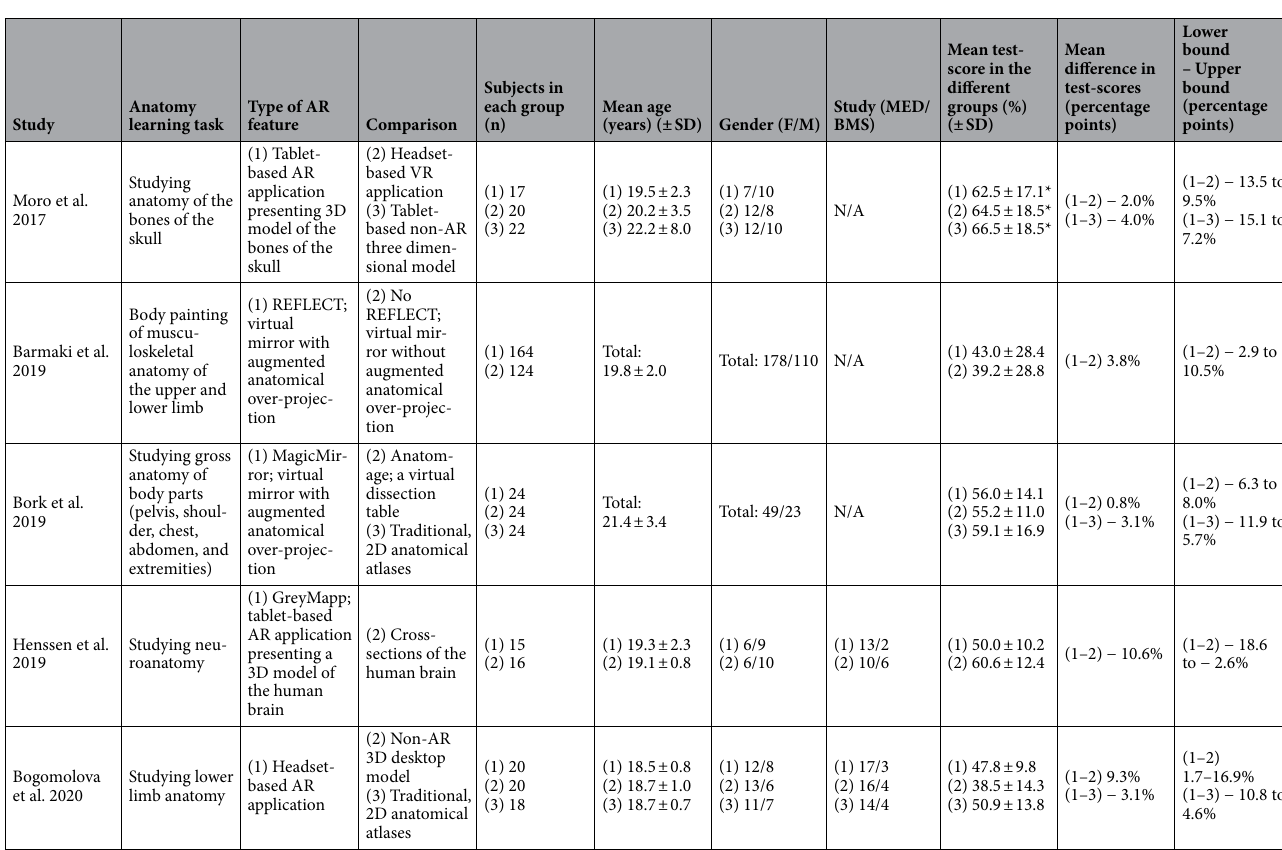
Table 2. Specifications of the included studies and characteristics of the included participants. AR augmented reality, BMS biomedical sciences, F female, M male, MED medicine, N/A not available, VR virtual reality. *Standard deviations were derived from Boxplot